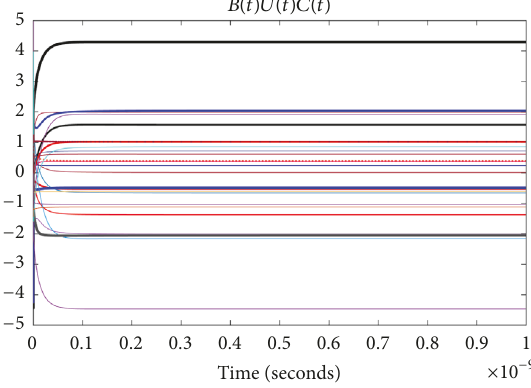
Figure 15: Trajectories of elements in 𝐵(𝑡)𝑈(𝑡)𝐶(𝑡) in the period of time [0,10 −9 ] .